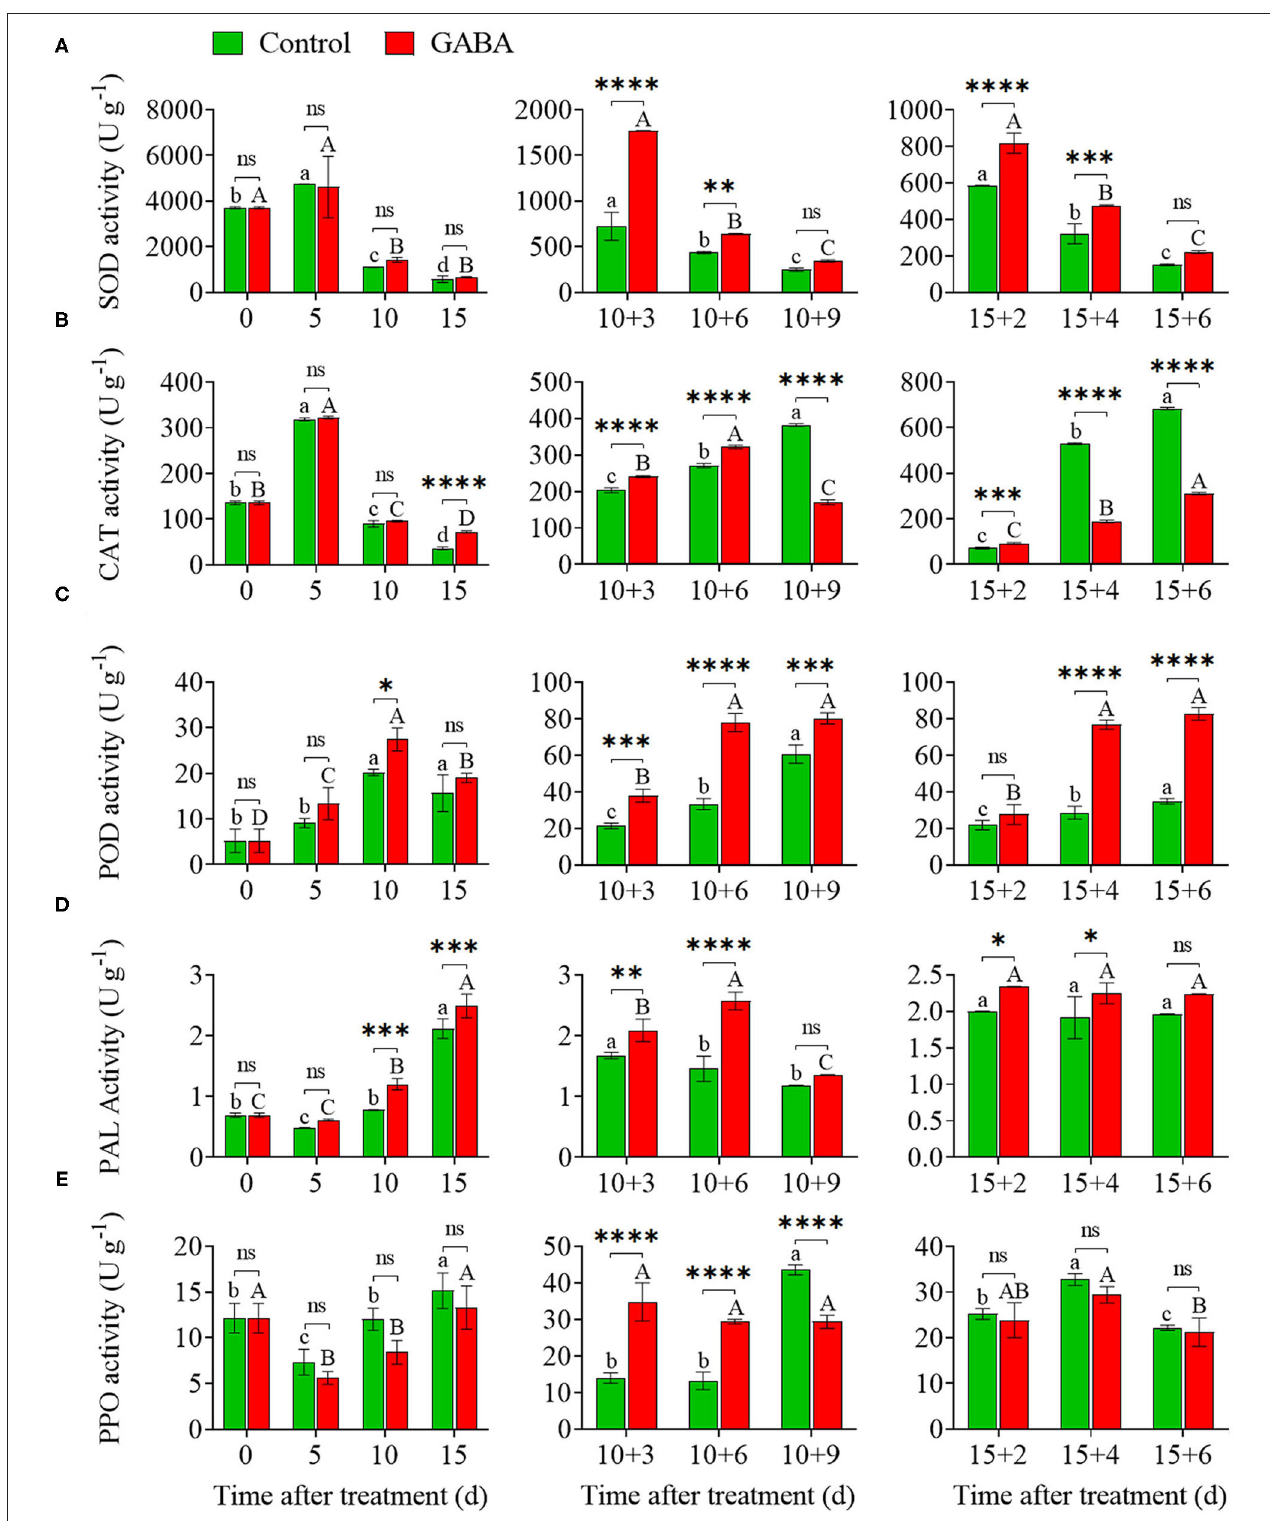
FIGURE 3 | The superoxide dismutase (SOD) (A) , catalase (CAT) (B) , peroxidase (POD) (C) , phenylalanine ammonia-lyase (PAL) (D) , and polyphenol oxidase (PPO) (E) activities of carambola fruit during storage at 4 and 25 ◦ C. Error bars are expressed as means ± SD (standard deviation) of three replicates ( n = 3). The asterisks indicate statistically significant differences between treatments at * p < 0.05, ** p < 0.01, *** p < 0.001, **** p < 0.0001, ns, not significant.